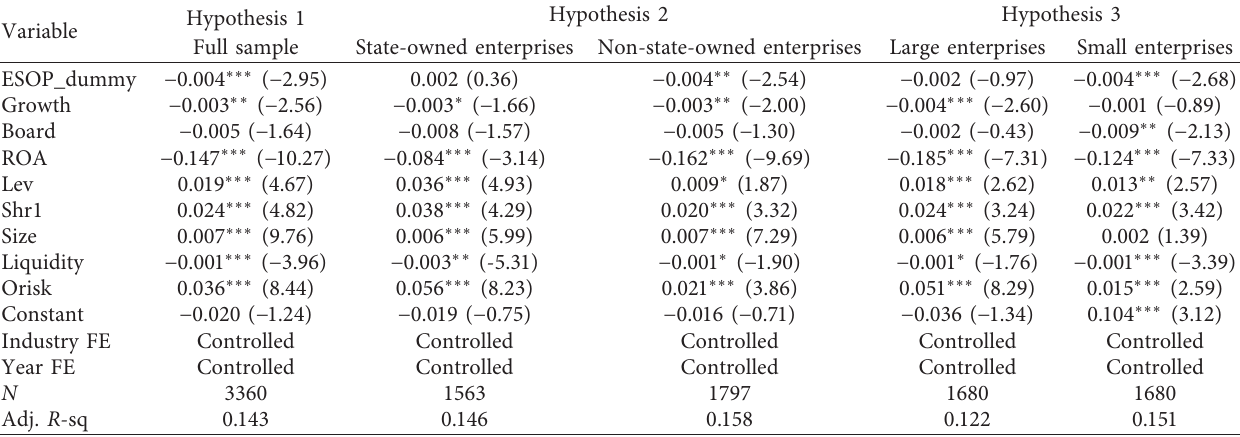
Table 4: Regression results: The impact of ESOP implementation on the cost of equity